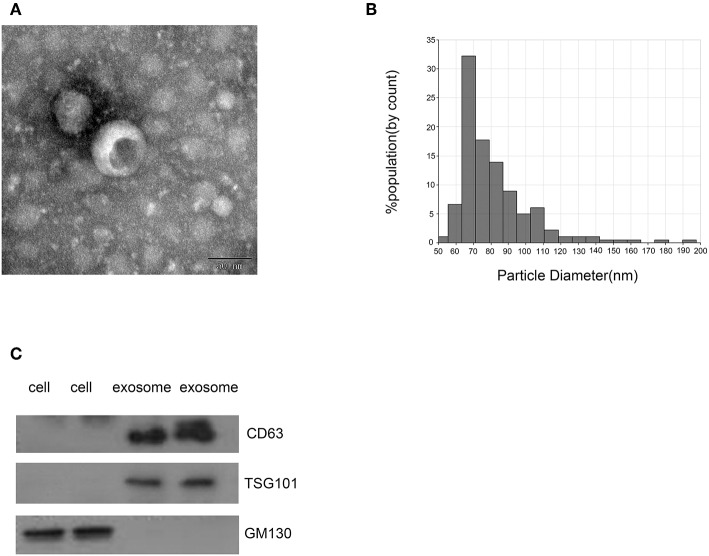
Identification of isolated exosomes. (A) TEM image showed representative data of exosomes from CRC patients with 50–150 nm diameter of the tumors (scale bar: 50 nm; high voltage (HV) = 100 kV). (B) Distribution of exosomes with 50–150 nm diameter; the samples were obtained from CRC patients based on the qNano system. (C) Western blot analysis of CD63, TSG101, and GM130 as exosomal markers.